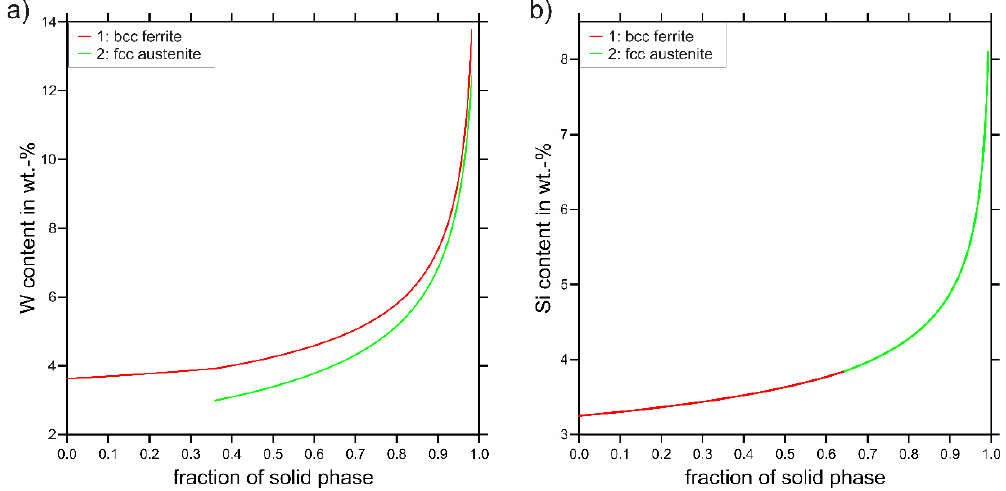
Figure 3. Element concentrations in the fcc and bcc phases, derived from Scheil–Gulliver solidification simulations. ( a ) W in the X2CrNiW15-9-5 steel and ( b ) Si in the X2CrNiSi18-9-4 steel (Thermo-Calc 2020b, TCFe10 database).